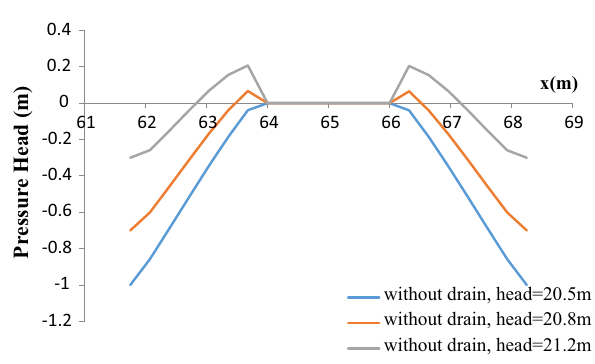
Fig. 13 Uplift forces for different water head